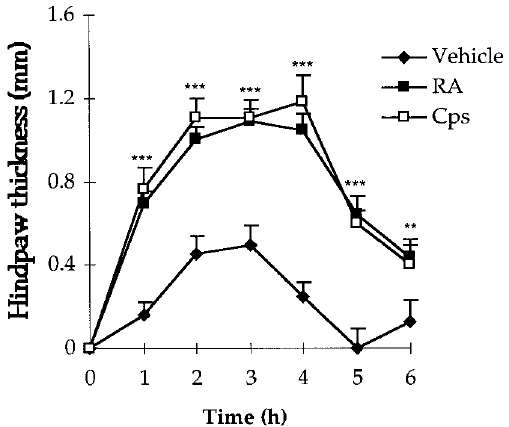
FIG. 1. Effects of vehicle, ricinoleic acid (RA, 0.9mg/mouse) or capsaicin (Cps, 0.09mg/mouse) on carrageenan-induced paw oedema expressed inmm. Ricinoleic acid, capsaicin and the vehicle were applied topically 30min before carrageenan injection. Data are mean ± standard error (SE). n = 5–8 for each group. ** p < 0.01; *** p < 0.001 versus vehicle group.